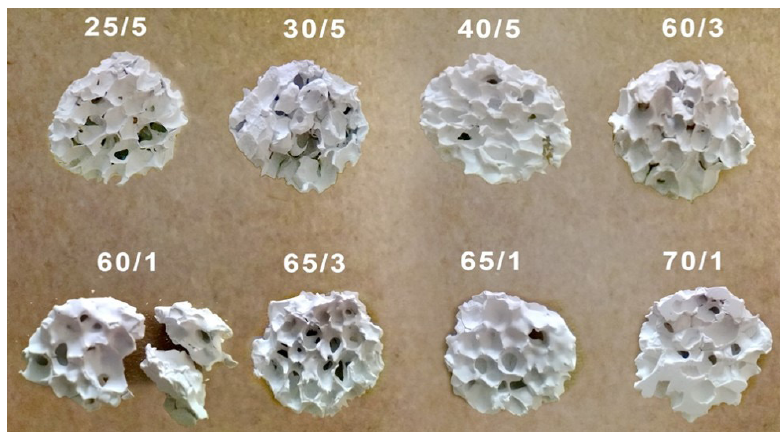
Figure 2. The integrity of heat-treated ZnO ceramics at 1000 ºC/2